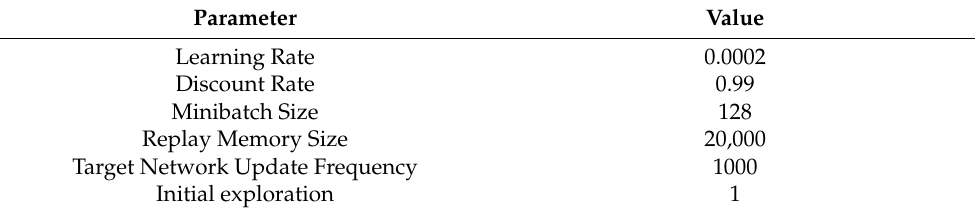
Table 2. Hyper parameters of the training algorithm.